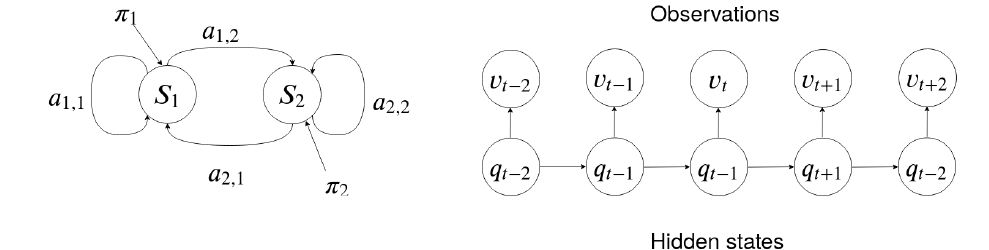
Figure 1. A graphical representation of an HMM with two hidden states on the left. On the right are transitions between a series of states and the observations emitted in each